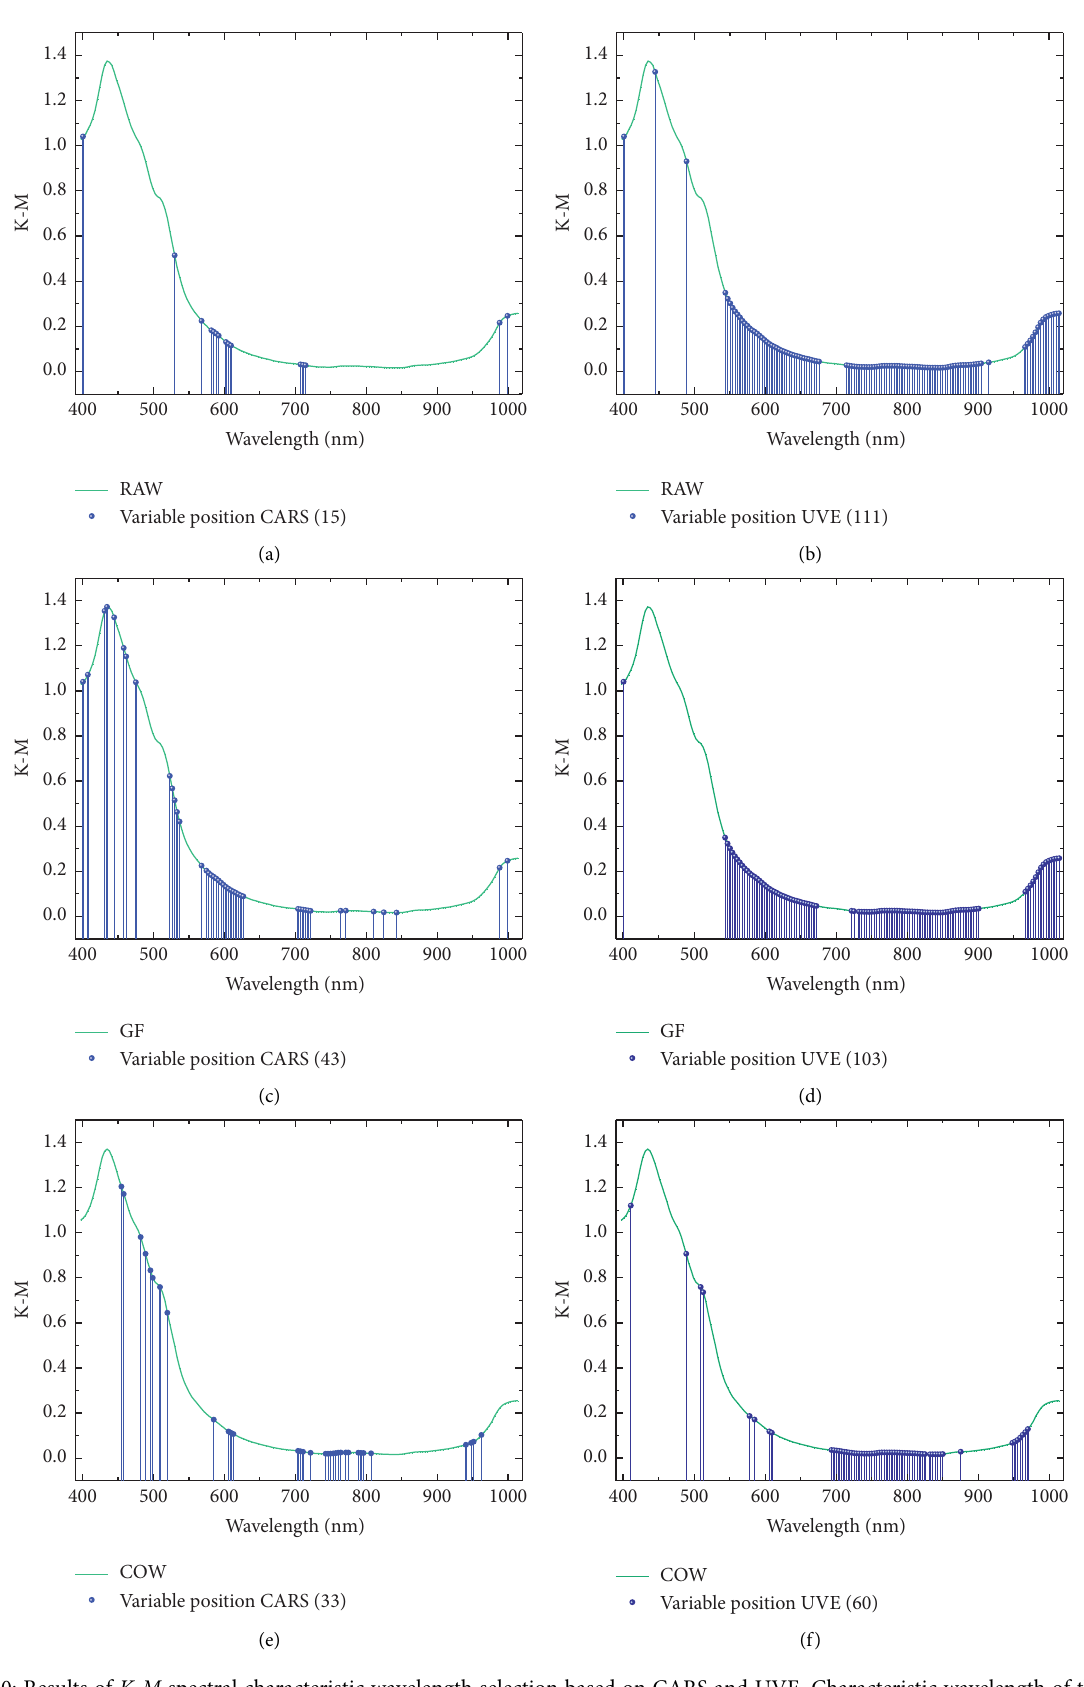
Figure 10: Results of K - M spectral characteristic wavelength selection based on CARS and UVE. Characteristic wavelength of the K-M- RAW spectra selected based on (a) CARS and (b) UVE. Characteristic wavelength of the K-M-GF spectra selected based on (c) CARS and (d) UVE. Characteristic wavelength of the K-M-COW spectra selected based on (e) CARS and (f)